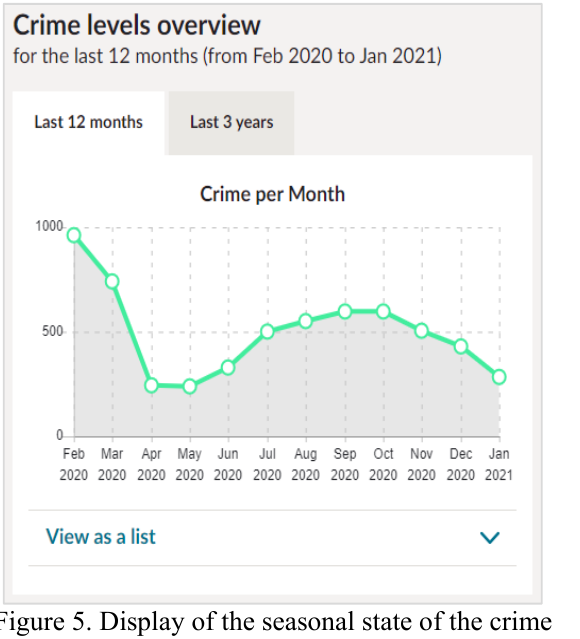
Figure 6. Display of the number of selected types of crimes of the locality